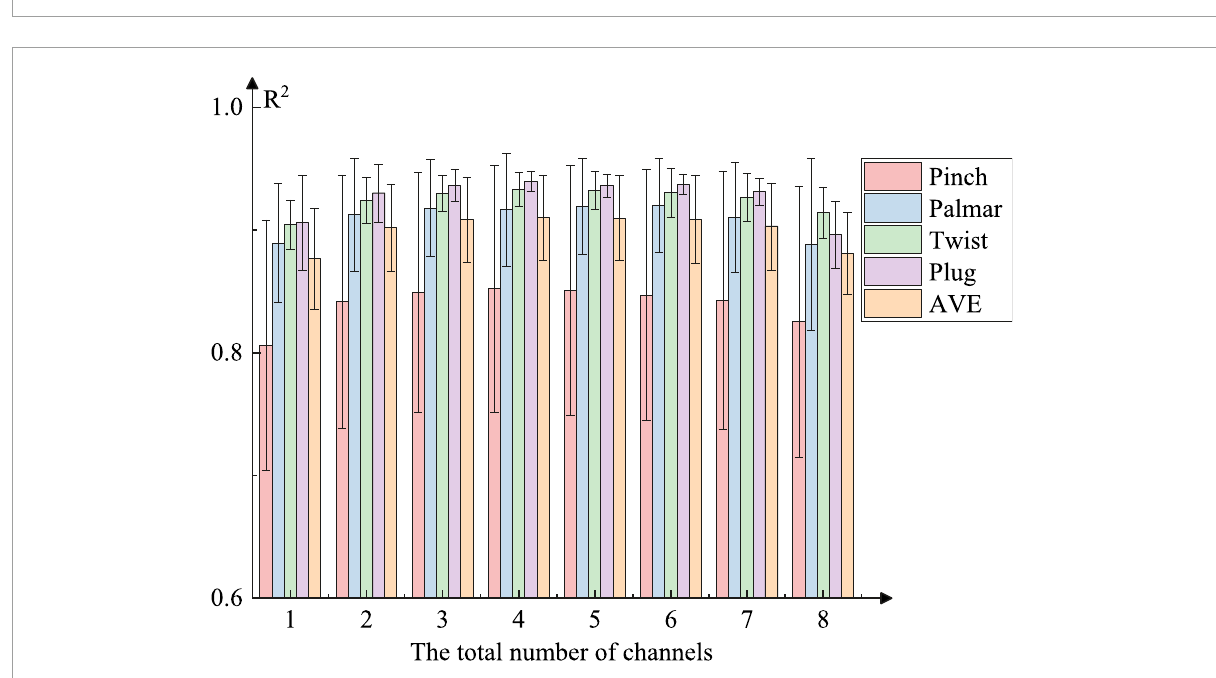
FIGURE8 Force estimation results of different natural grasping movements (Take the step-climbing profile as an example). All the combinations were tested and the range of R 2 is indicated. The bars were plotted with the mean